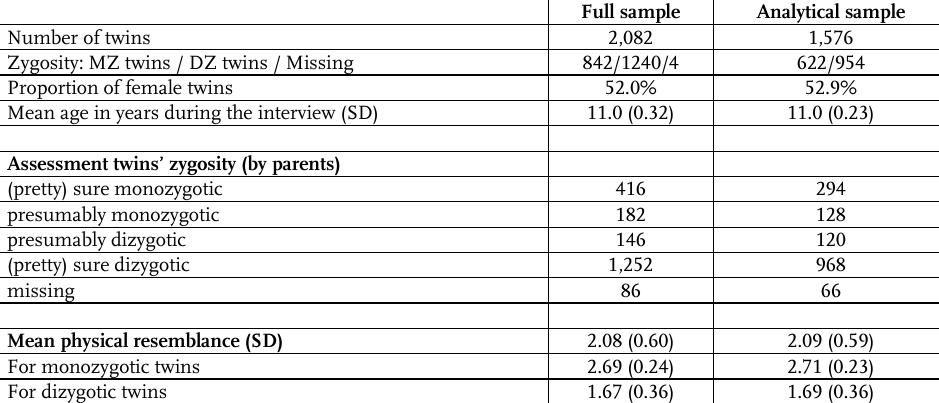
Table 1 : Sample demographics for TwinLife (cohort 2)